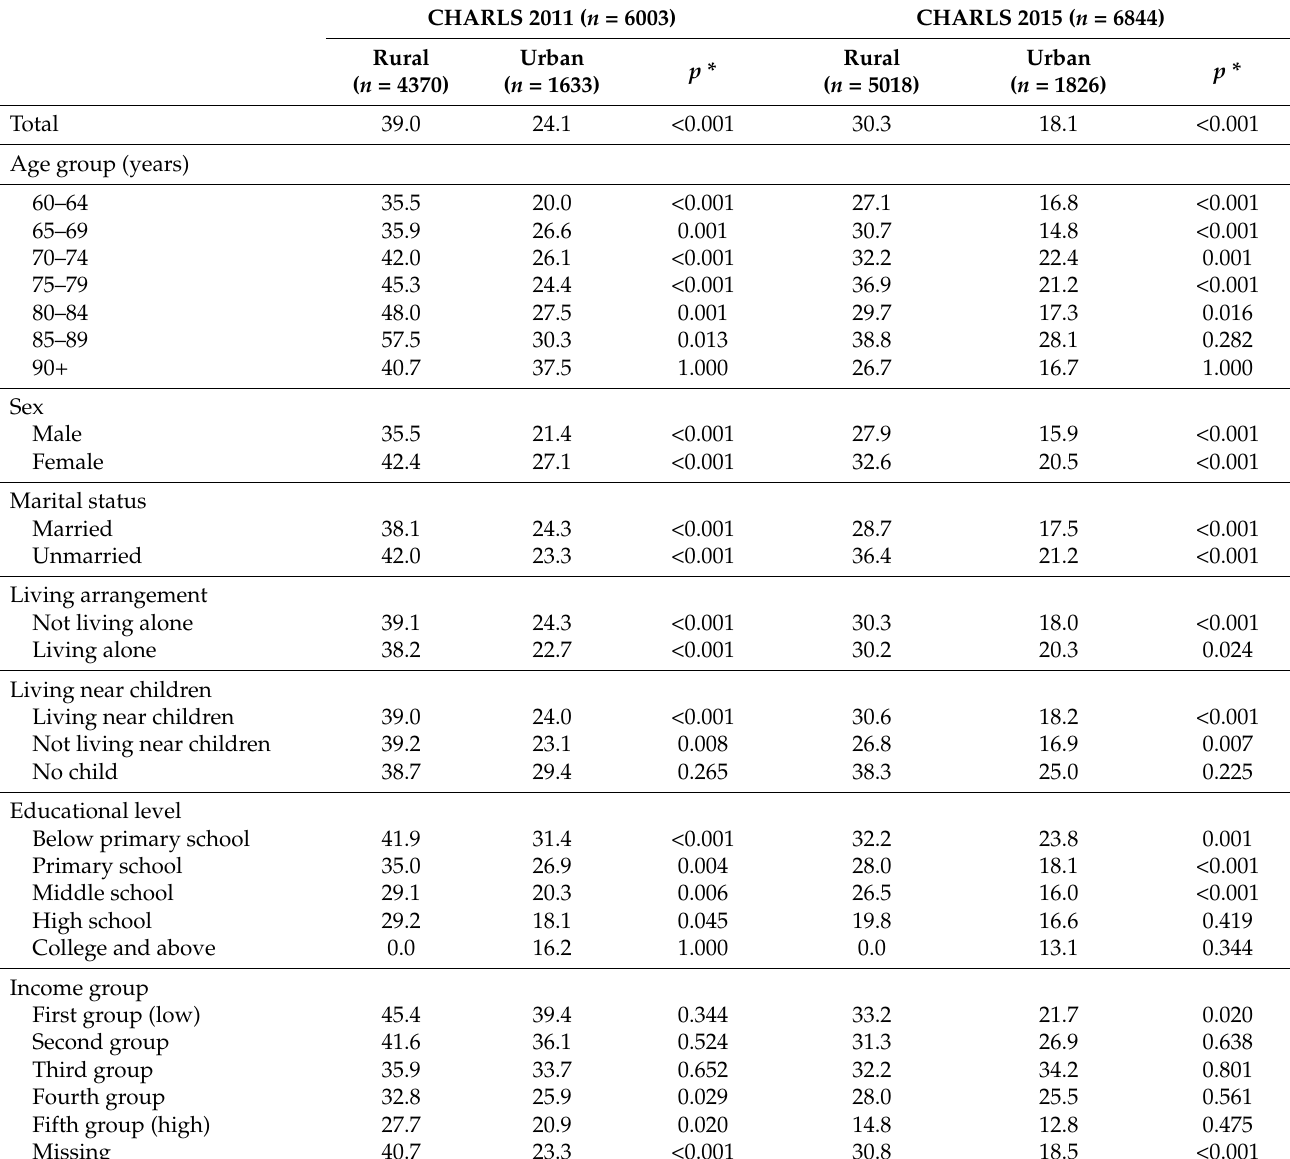
Table 4. Prevalence (%) of poor Self-Rated Health (SRH) among rural and urban respondents, CHARLS 2011 and CHARLS 2015, by individual